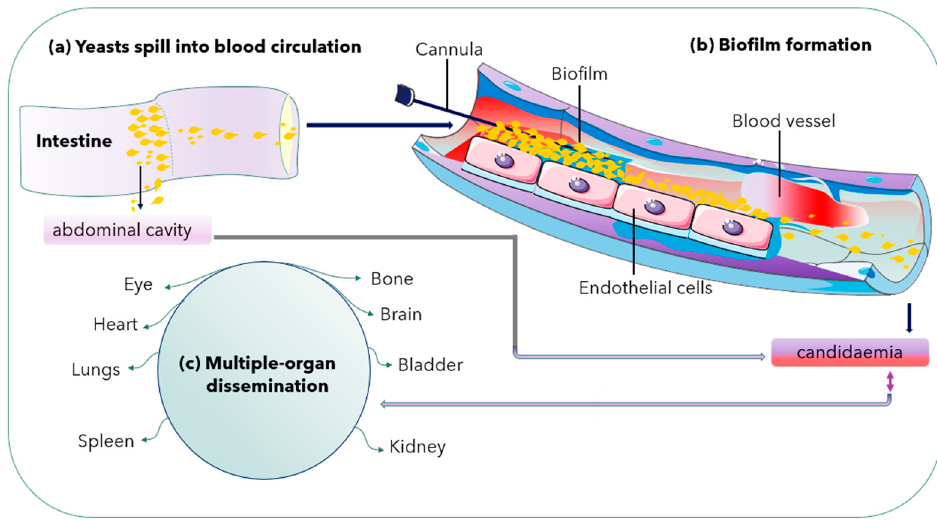
Figure 2. Biofilm formation in a blood vessel and dissemination into multiple organs. Double arrow shows either way dissemination of C. glabrata cells.